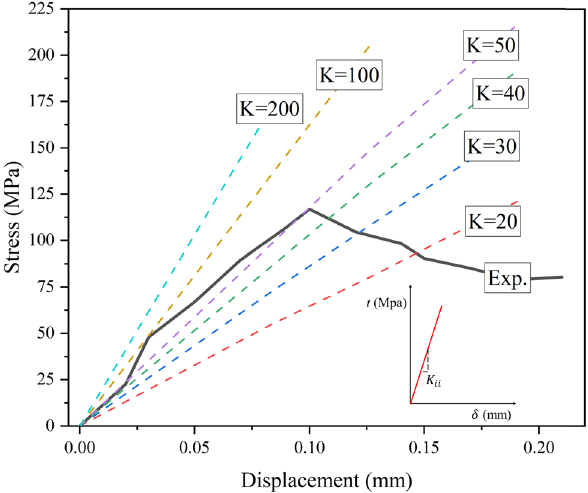
Figure 15: Determination of interfacial sti ff ness, K , according to the comparison of the experimental test and predicted